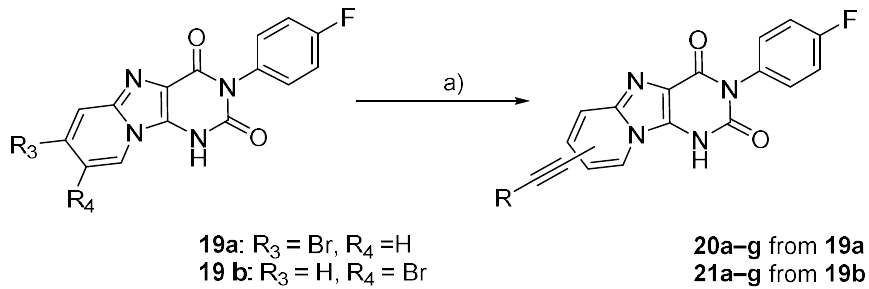
Table 5. SAR of the C 7 and C 8 moiety by Sonogashira cross-coupling and Mtb ThyX inhibition at 200 µM by the NADPH oxidase